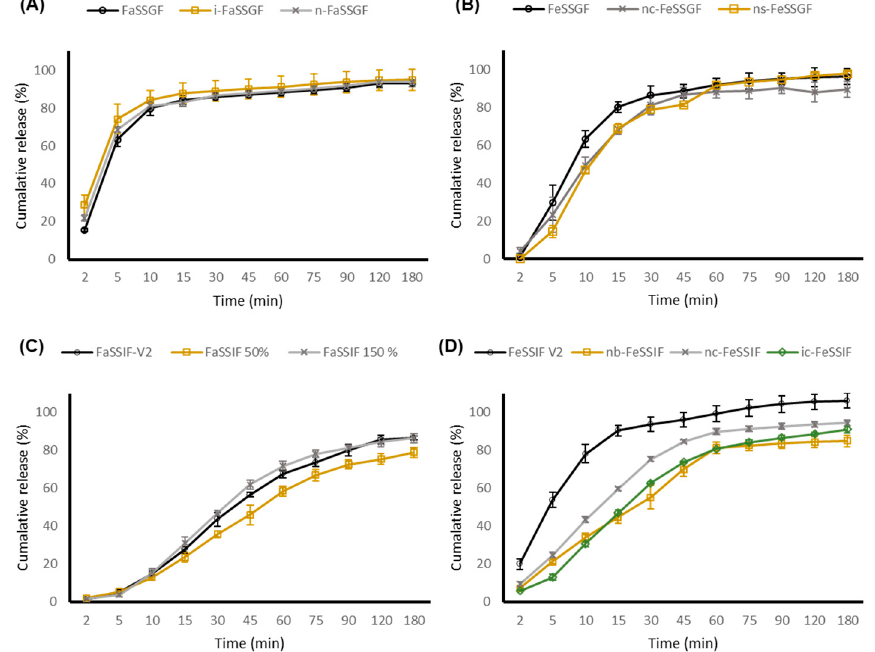
Figure 3. Dissolution profile of carvedilol 2 mg ODMT in adult and paediatric biorelevant media. Data presented as mean ± standard deviation ( n = 6). ( A ) FaSSGF = Adult Fasted-state Simulated Gastric Fluid, ( B ) FeSSGF = Adult Fed-state Simulated Gastric Fluid, ( C ) FaSSIF-V2 = Adult Fasted- state Simulated Intestinal Fluid, and ( D ) FeSSIF = Fed-state Simulated Intestinal Fluid. i = infant, n = neonate, c = cow-based milk formula, s = soy-based milk formula, and b = breast fed.